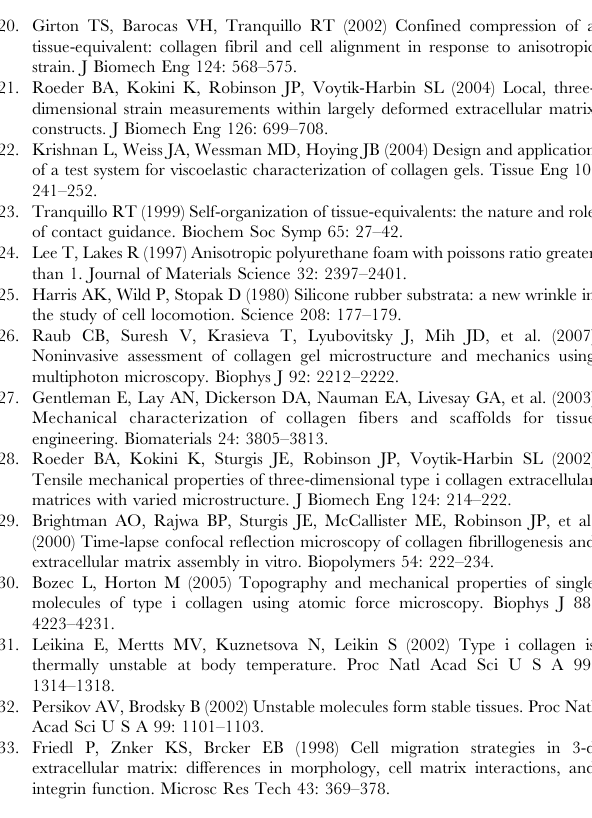
Figure S1 (A) Example of a simulated random network of sticks in two dimensions. (B) Same example, after blurring and added Gaussian noise. (C) Color-coded local stick orientation, as determined by our image processing algorithm. Angle color scale at bottom. Found at: doi:10.1371/journal.pone.0005902.s002 (0.80 MB TIF) Figure S2 Known and calculated (A) probability density functions and (B) cumulative distribution functions of the orientation of individual sticks, based on image shown in Figure S1A. Found at: doi:10.1371/journal.pone.0005902.s003 (0.23 MB TIF)